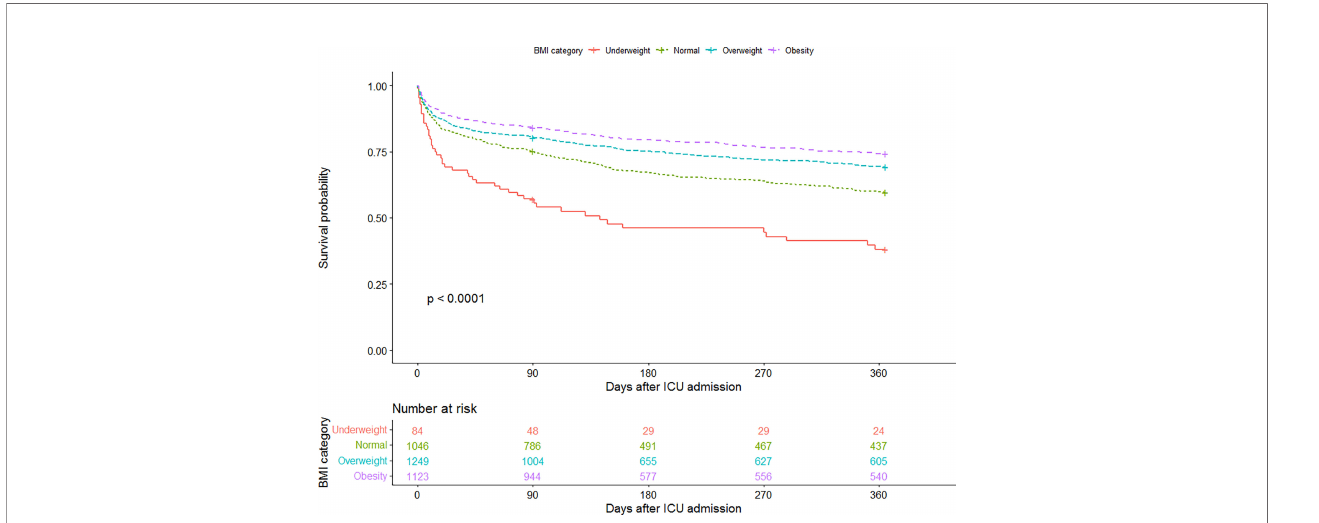
FIGURE 3 | Kaplan-Meier curve for 1-year survival by BMI category. The number at risk represents the patients ’ number in each BMI category at the start of each time period.